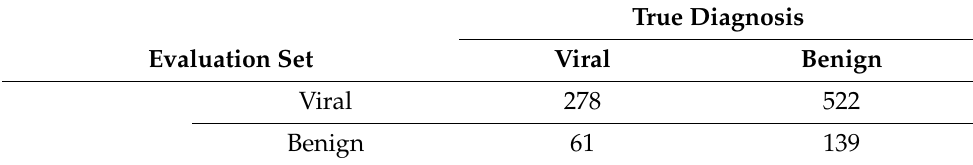
Table 21. OC-SVM model: